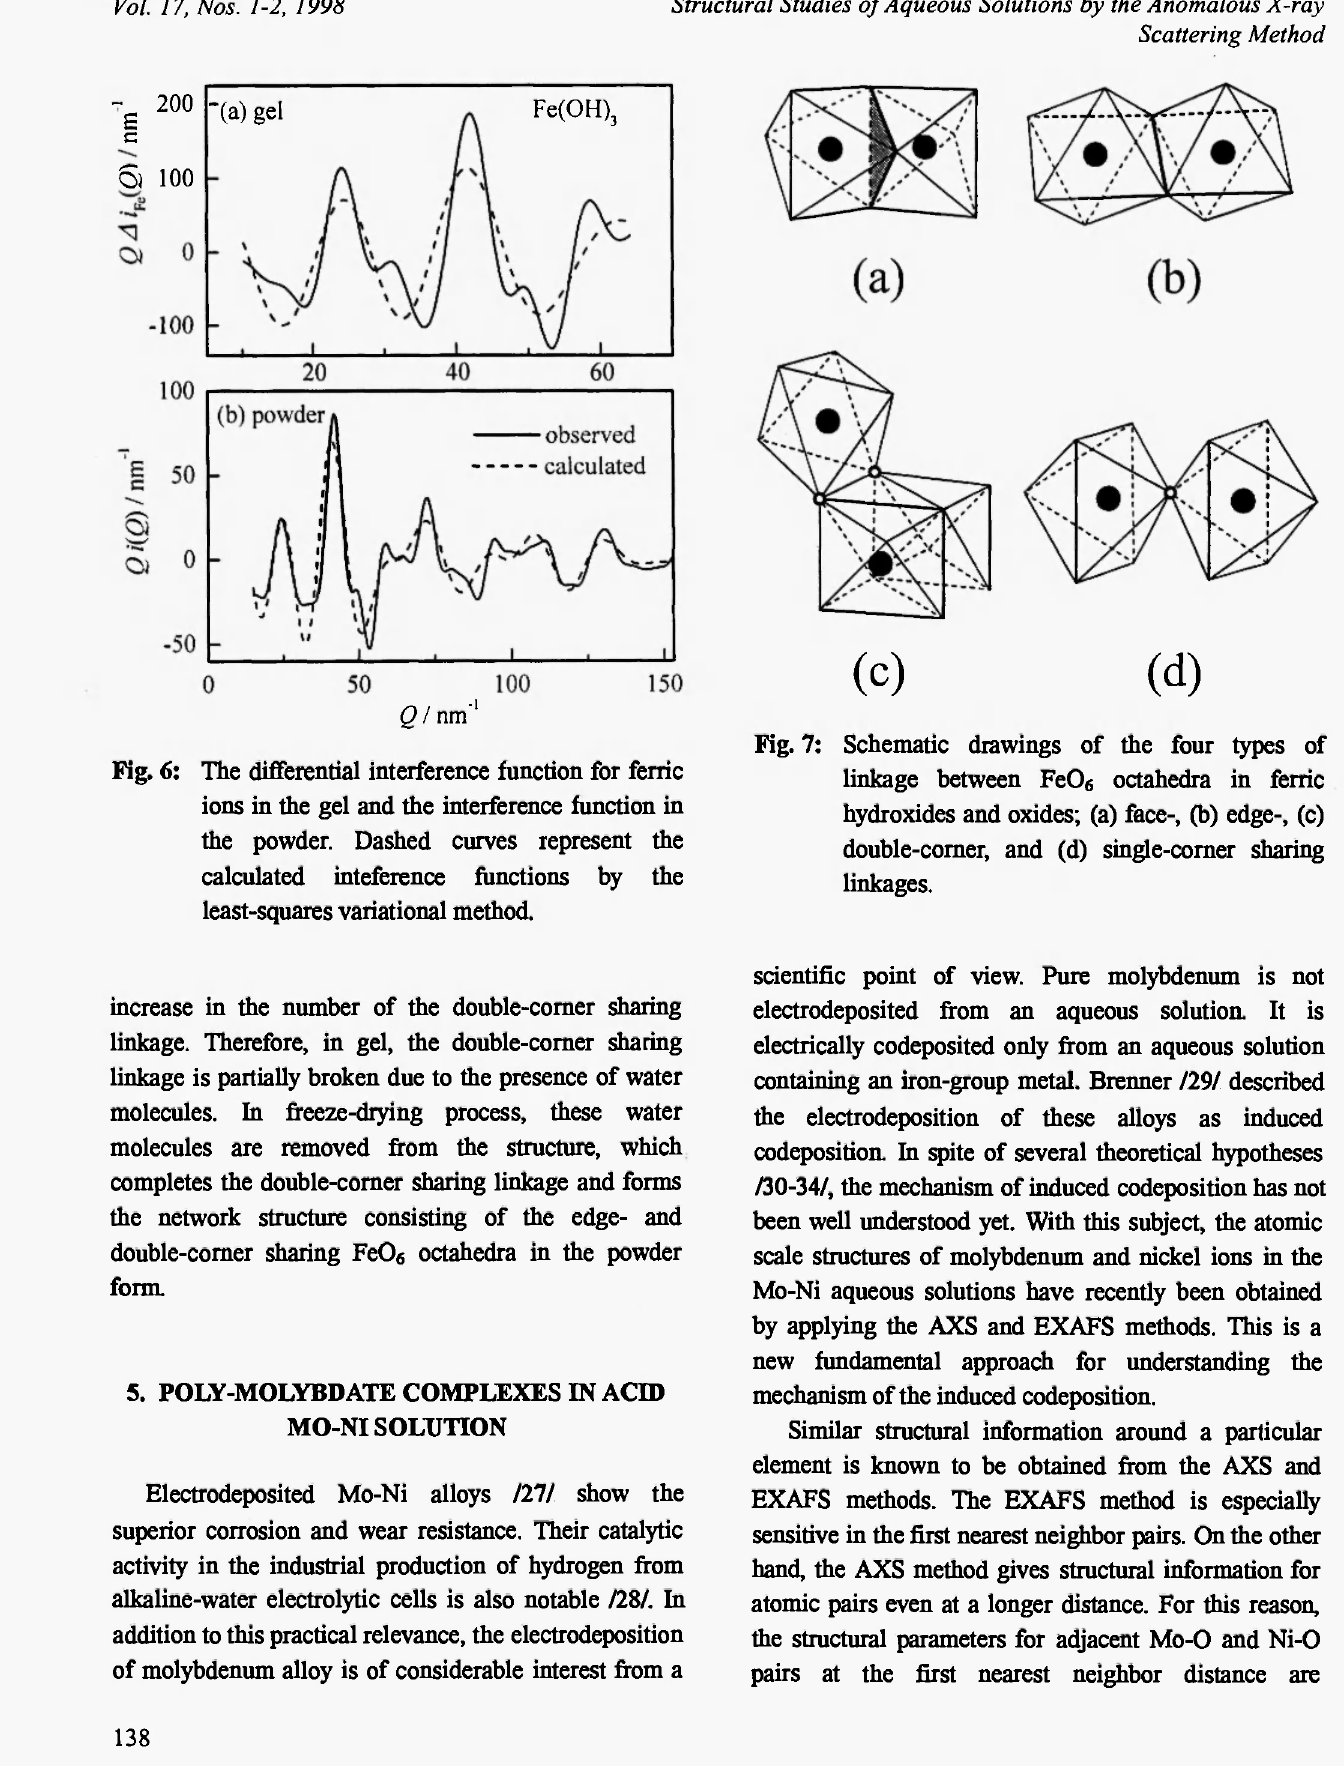
Fig. 6: The differential interference function for ferric ions in the gel and the interference function in the powder. Dashed curves represent the calculated inteference functions by the least-squares variational method.